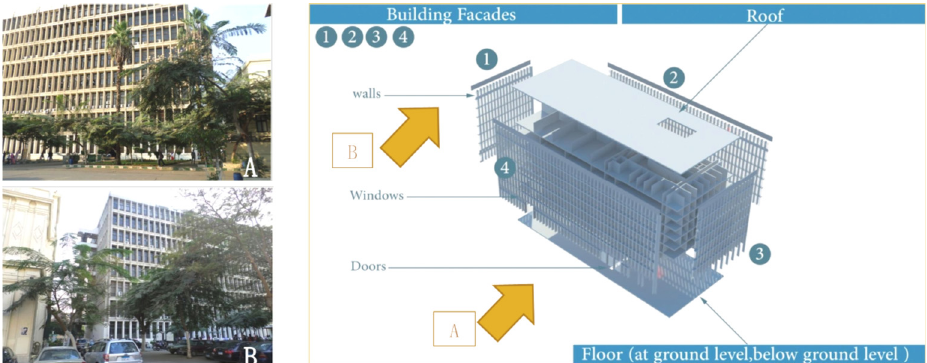
Fig. 5. The building envelop components.